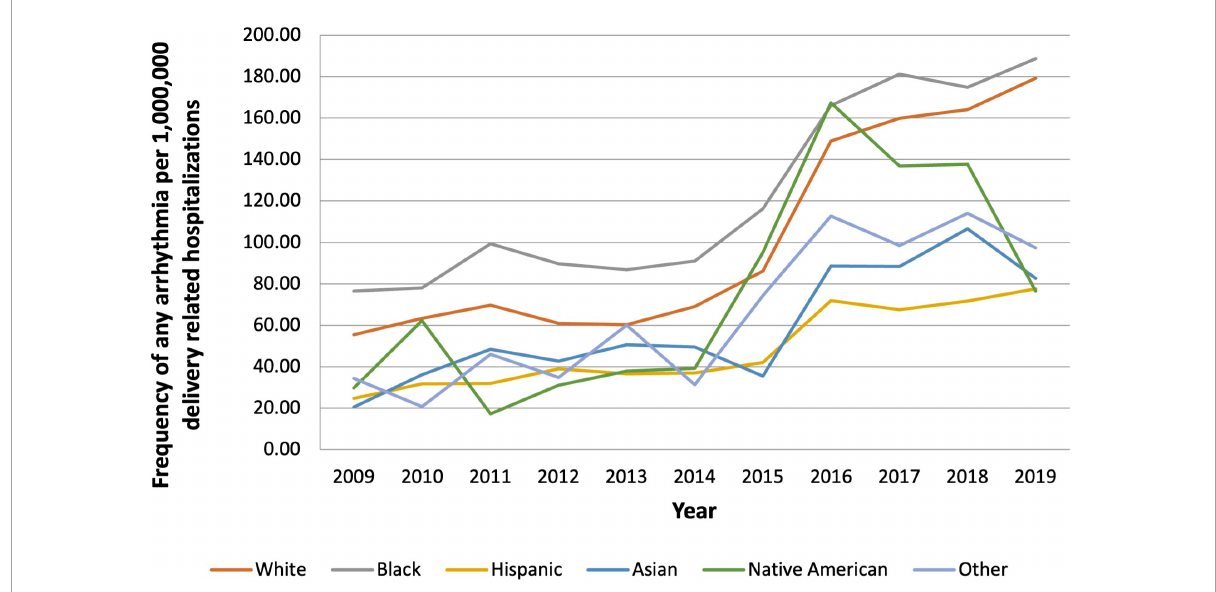
FIGURE5 Frequency of any arrhythmia per 1,000,000 delivery related hospitalizations from 2009 to 2019, stratified by race.